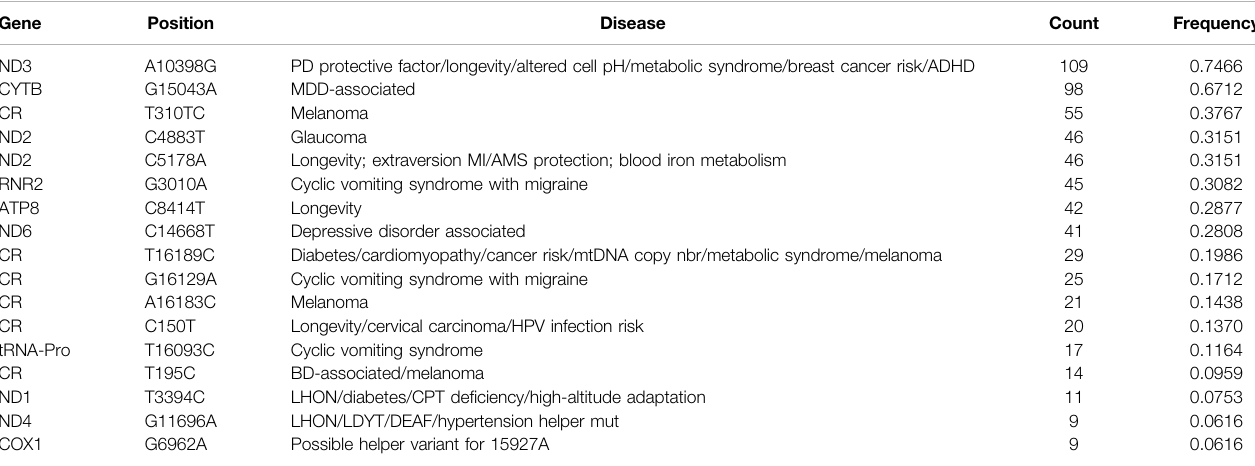
TABLE 2 | 17 disease-related sites in the mitochondrial genome of the Daur ethnic